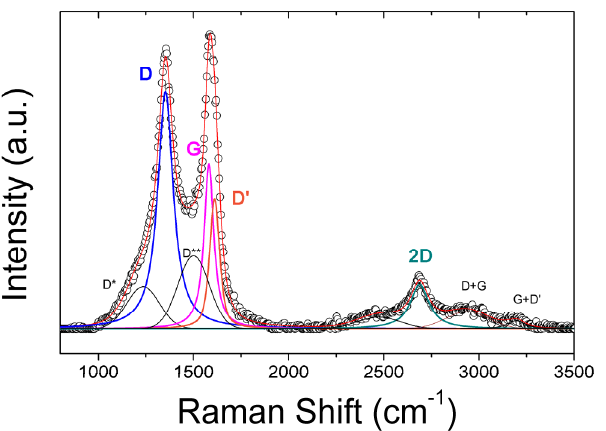
Figure 1. Typical Raman spectra of the rGO used in this work. Highlighted peaks in this figure corresponds to the D (blue), G (pink), D’ (orange), and the second order 2D’. Black peaks represent other defect activated vibration modes such as D*, D**, D+G. G+D’.